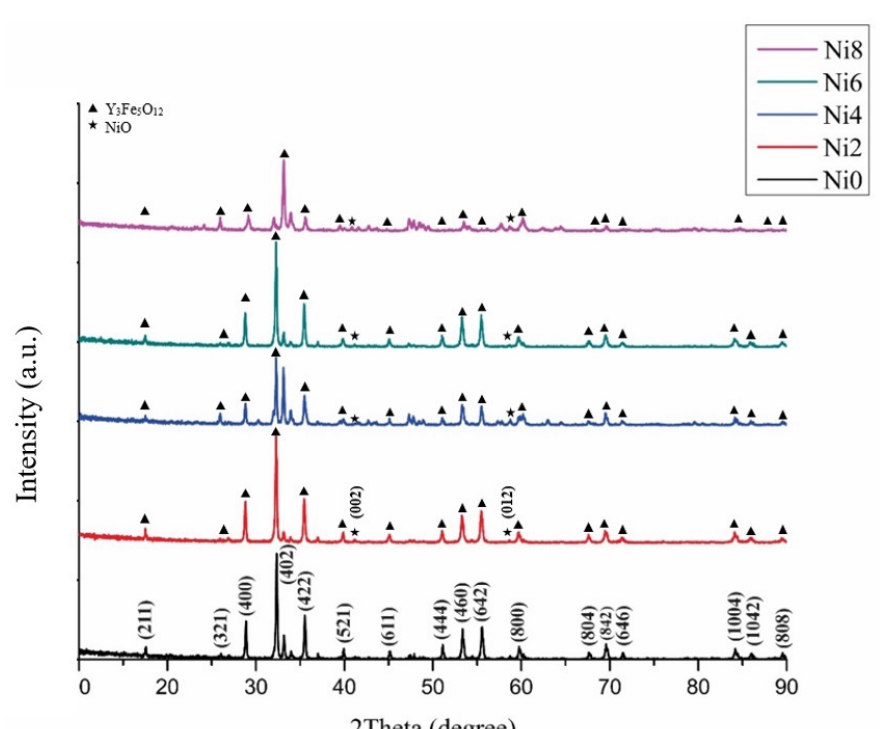
Figure 3. Phase identification of Yttrium Iron Nickel Garnet (YIG) in various